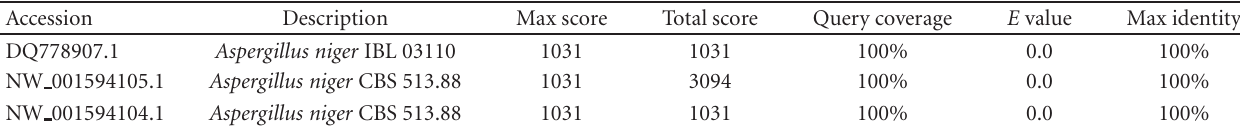
Figure 2: (a) Response surface for the e ff ects of cellobiose (%) and yeast extract (%) at 1.6% (NH 4 ) 2 SO 4 and pH 6 on the specific activity after 240h of incubation. (b) Response surface for the e ff ects of cellobiose (%) and (NH 4 ) 2 SO 4 (%) at 0.5% yeast extract and pH 6 on the specific activity after 240h of incubation. (c) Response surface for the e ff ects of cellobiose (%) and pH at 1.6% (NH 4 ) 2 SO 4 and 0.5% yeast extract on the specific activity after 240h of incubation. (d) Response surface for the e ff ects of yeast extract (%) and (NH 4 ) 2 SO 4 (%) at 1.75% cellobiose and pH 6 on the specific activity after 240h of incubation. (e) Response surface for the e ff ects of yeast extract (%) and pH at 1.75% cellobiose and 1.6% (NH 4 ) 2 SO 4 on the specific activity after 240h of incubation. (f) Response surface for the e ff ects of (NH 4 ) 2 SO 4 (%) and pH at 1.75% cellobiose and 0.5% yeast extract on the specific activity after 240h of incubation. Table 3: Aspergillus SOI017 compared with three high-score sequences of BLAST search based on ITS